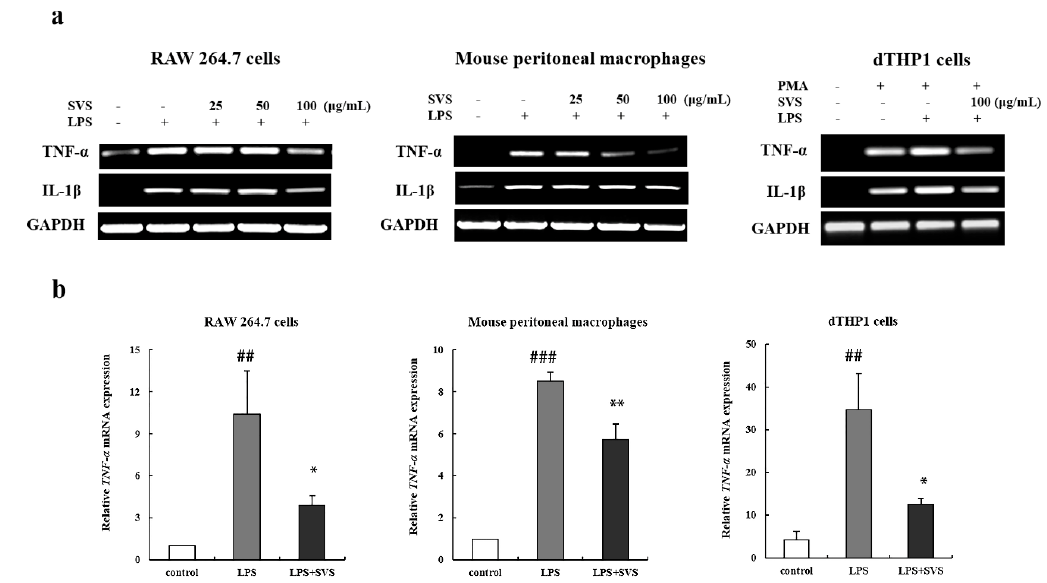
Figure 1. Stevioside inhibited IL-6 expression in lipopolysaccharide (LPS)-induced macrophages. ( a ) Effect of stevioside on the viability of RAW 264.7 cells. Cells were treated with or without stevioside at 0, 6.25, 12.5, 25, 50, 100, 200, and 400 μ g/mL with LPS (1 μ g/mL). At 24 h post-treatment, 20 μ L MTT was added to each well for an additional 4 h of incubation. Cell viability was expressed as a percentage of the control; ( b , c ) Macrophages were pretreated with or without stevioside (25, 50, or 100 μ g/mL) for 1 h and then stimulated with LPS (1 μ g/mL) for 9 h. RT-PCR ( b ) and RT-qPCR analysis ( c ) were used to detect and quantify IL-6 transcripts; ( d ) Macrophages were pretreated with or without stevioside (100 μ g/mL) for 1 h followed by LPS (1 μ g/mL) stimulation for another 24 h. IL-6 levels in the culture supernatant were determined by ELISA; ( e ) RAW 264.7 cells were pretreated with or without stevioside (25, 50, or 100 μ g/mL) for 1 h and then stimulated with LPS (1 μ g/mL) for 12 h. IL-6 expression was detected by Western blot. GAPDH was used as an internal control. Quantification of IL-6 levels is shown in the left panel, as measured by image J. Experiments were repeated three times. ## p < 0.01, ### p < 0.001 versus control group; * p < 0.05; ** p < 0.01 versus LPS-treated group. SVS,